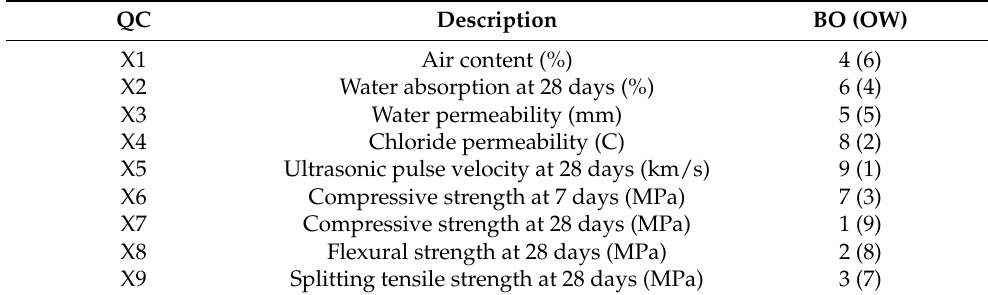
Table 4. BO and OW vectors of nine